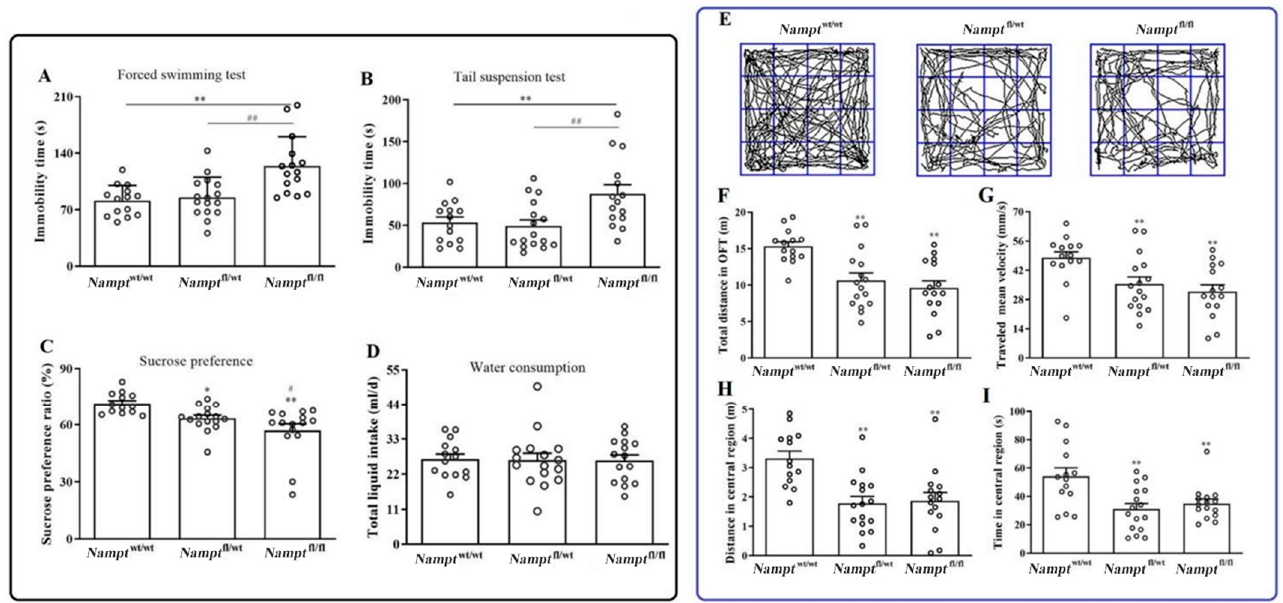
Figure 3. Behavioral assessment using FST, TST, SPT, and OFT in Nampt flox/flox mice. ( A ) Immobility in FST. ( B ) Immobility in TST. ( C ) Sucrose preference ratios in SPT. ( D ) Total liquid intakes in SPT. ( E ) Typical tracks in OFT. ( F ) Total distances covered in OFT. ( G ) Mean velocities in OFT. ( H ) Dis- tances in the center. ( I ) Total time spent in the center. * p < 0.05, ** p < 0.01 vs. Nampt wt/wt mice; # p < 0.05, ## p < 0.01 vs. Nampt fl/wt mice.